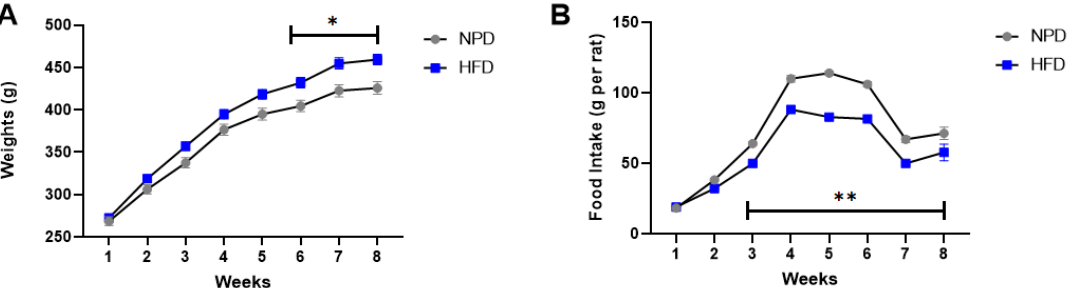
Figure 1. Body weights and food intake in NPD and HFD experimental groups for 8 weeks (T1) of HFD diet. ( A ) Weights. Body weight gains (g) difference between NPD and HFD groups in 8 weeks of HFD. ( B ) Food intake. Food intake (g per cage) difference in NPD and HFD groups in 8 weeks of HFD. Statistical significance indicated for (*) p < 0.05 and (**) p < 0.001.